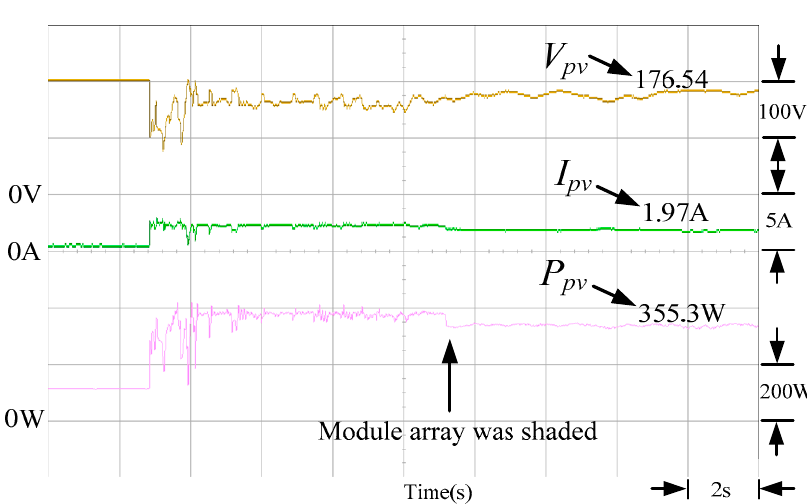
Figure 14. Case 4 measured results of maximum power point tracking by using TLBO algorithm.